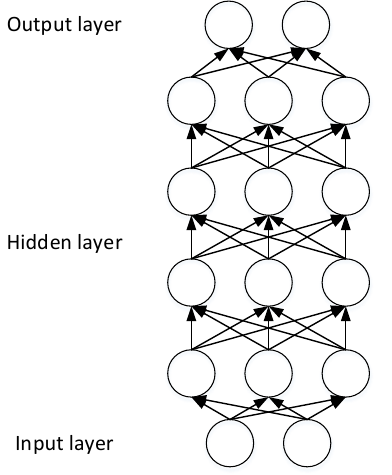
Figure 6. The structure of the DNN.